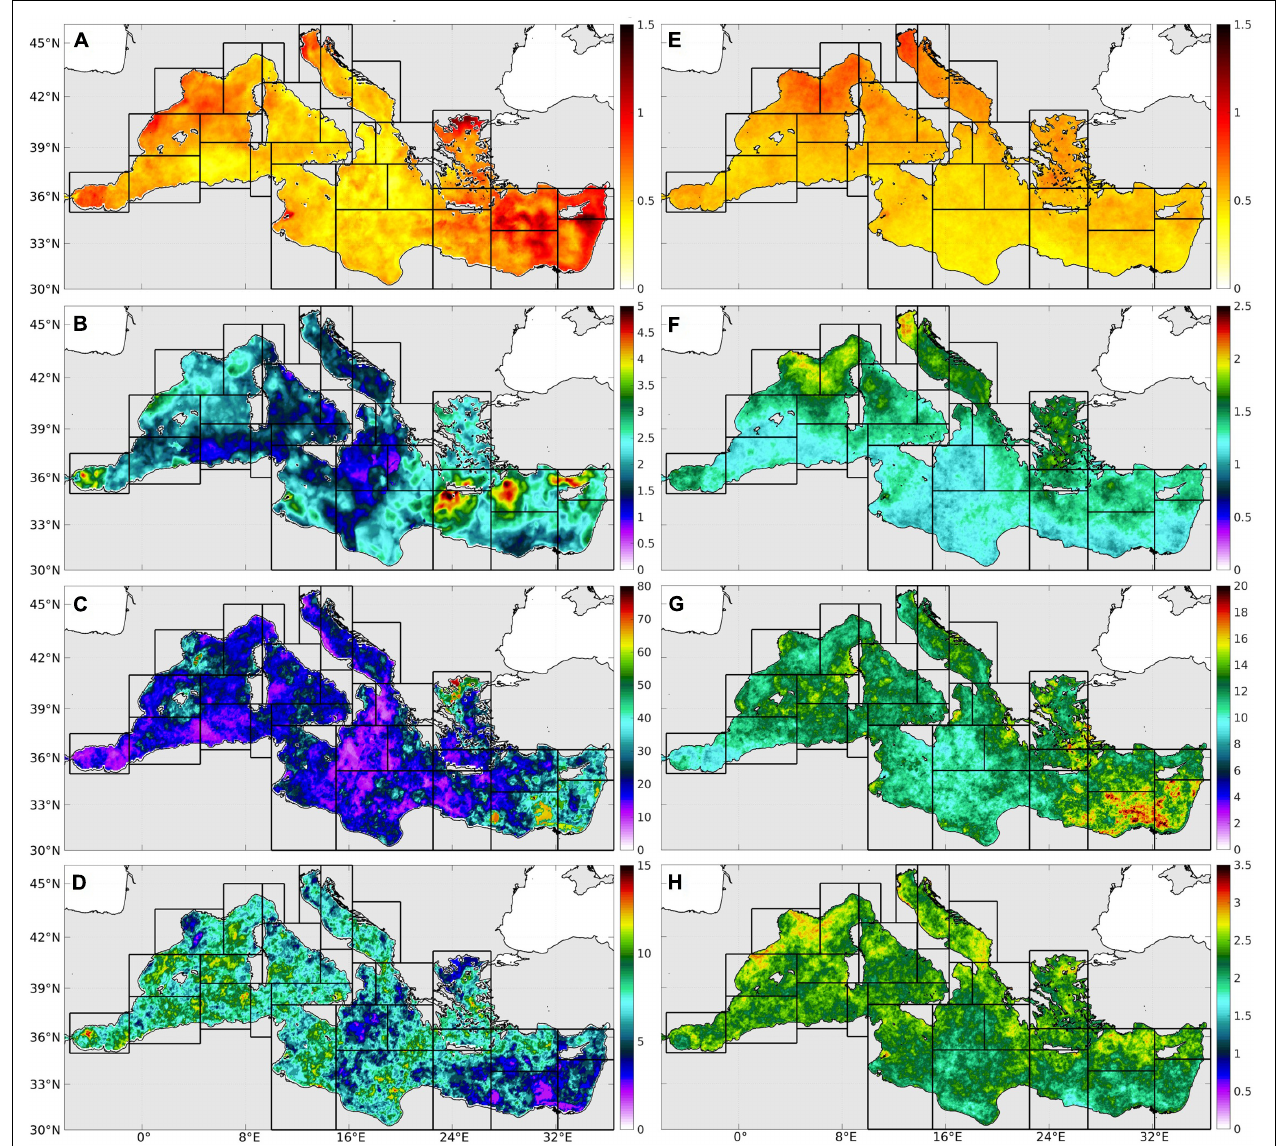
FIGURE 5 | Annual MHW indices in 2020 (A–D) and averaged over the period 1982–2020 (E–H) : mean intensity (A,E) and maximum intensity (B,F) (in ◦ C), mean duration (C,G) (in days), and number of events (D,H) .